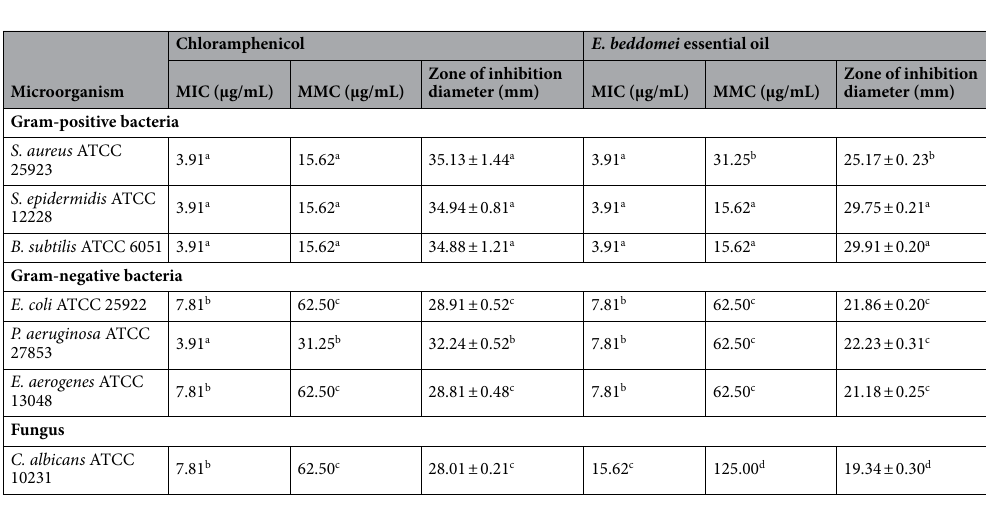
Table 3. Antimicrobial activity of E. beddomei essential oil and chloramphenicol. The data are mean ± standard deviation. Different letters indicate significant differences ( p <